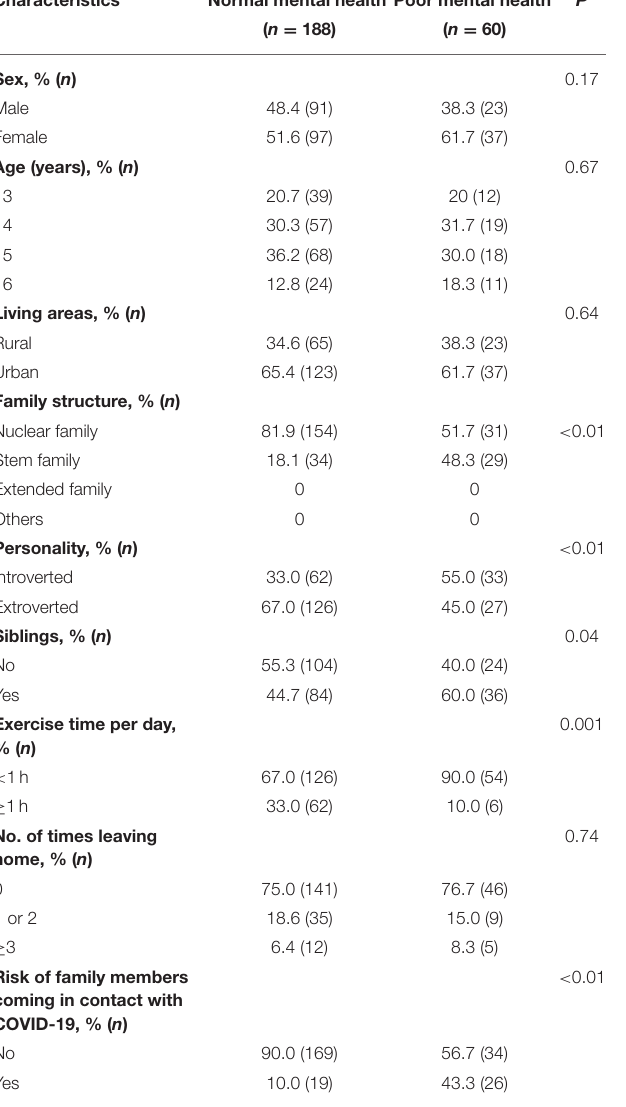
TABLE 2 | Comparison of sociodemographic features between adolescents with normal and poor mental health during the COVID-19 epidemic. Characteristics